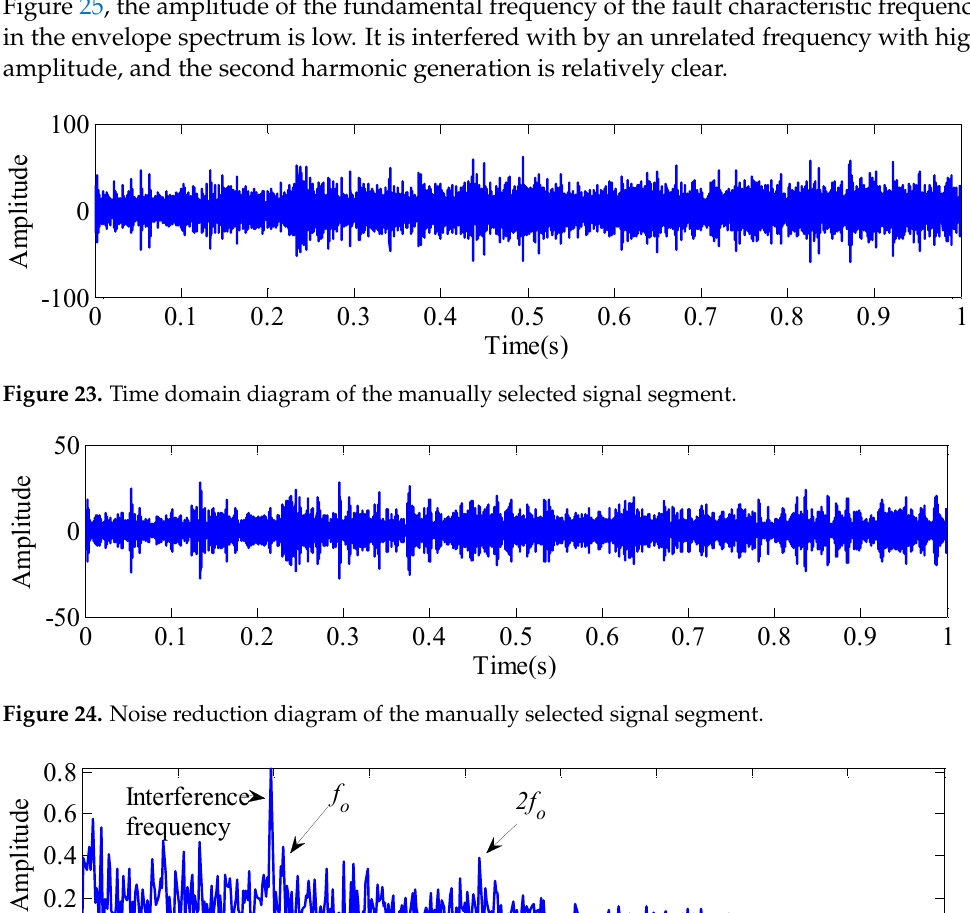
Figure 27. Noise reduction diagram of the signal segment selected by the algorithm in this paper. Figure 28. The noise reduction envelope spectrum of the signal segment selected by the algorithm in this paper. 4. Discussion The proposed method in this paper provides an idea for data selection and filtering noise reduction for axle box bearing fault diagnosis, and has a good effect in most cases, but it still fails to collect vibration signals under some extreme conditions. For example, when the train runs on a section of track with intensive shortwave defects, the high am- plitude impulse of the collected vibration signals will become intensive. This may lead to a failure to select high-quality signal segments after the pre-identification signal, and sub- sequent diagnosis is still difficult. 5. Conclusions In the process of high-speed train operation, when there are shortwave defects on the track, it will cause a large amplitude wheel–rail impulse in the collected vibration signal, which will interfere with the fault diagnosis. In this study, a pre-identifying singular value decomposition algorithm is proposed. According to the characteristics of time domain signals that are cyclostationary and strong during the high-speed operation of axle box bearings, a method is proposed to use the kurtosis index to be sensitive to a single impulse. The signal is segmented by seconds, and the kurtosis index of each signal segment is cal- culated separately. Then, the kurtosis index is arranged in order from small to large, and